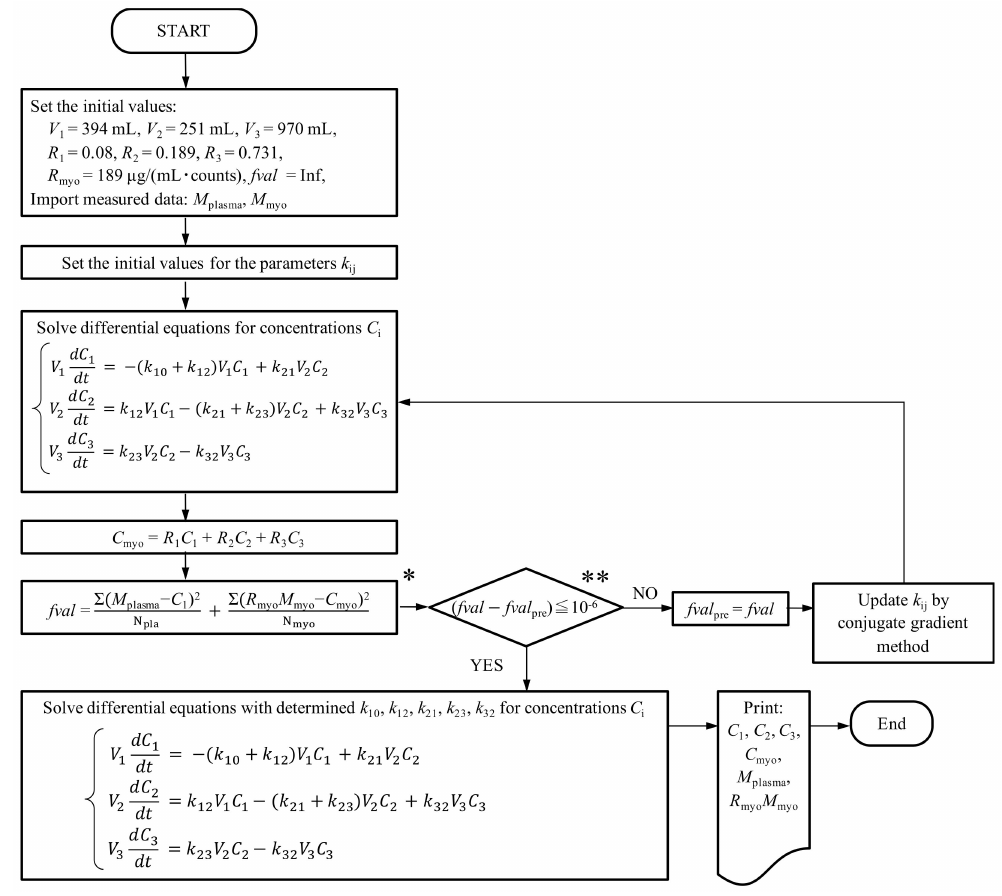
Figure 4. Diagram of the proposed optimization procedure. (* N pla and N myo represent the number of data points for the plasma concentration and myocardial fluorescence, respectively. ** fval pre represents the previously calculated value of fval